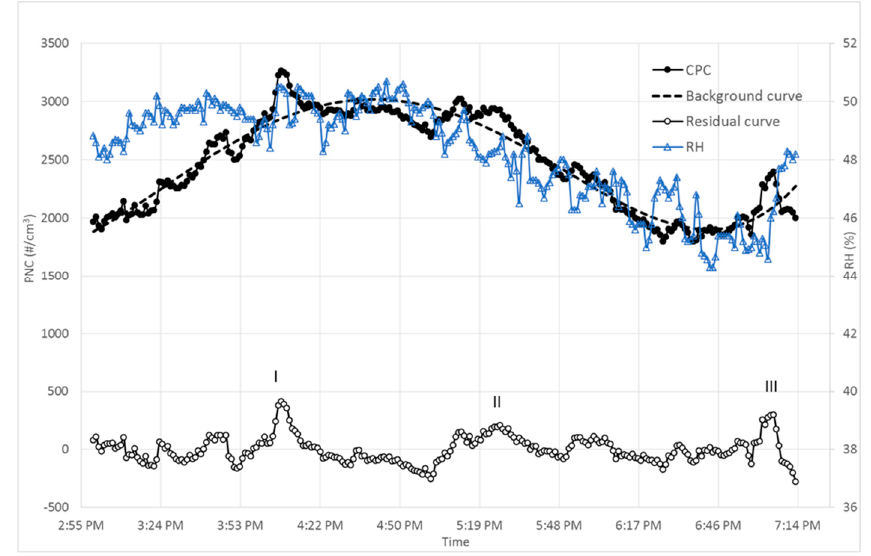
Figure 6. NP laboratory: PNC curve (solid black line + solid dots), background curve (dashed black line) and residual curve (black line + empty dots) as the difference between the PNC curve and the background curve, and the relative humidity curve (blue line + triangles).